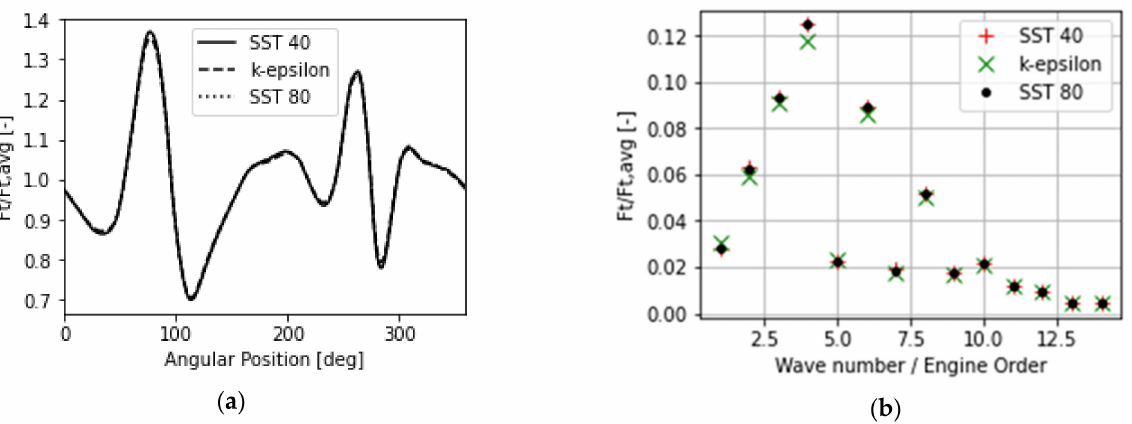
Figure 4. Comparing sensitivities to turbulence model and time stepping. ( a ) On the force as a function of time; ( b ) on the force per wave